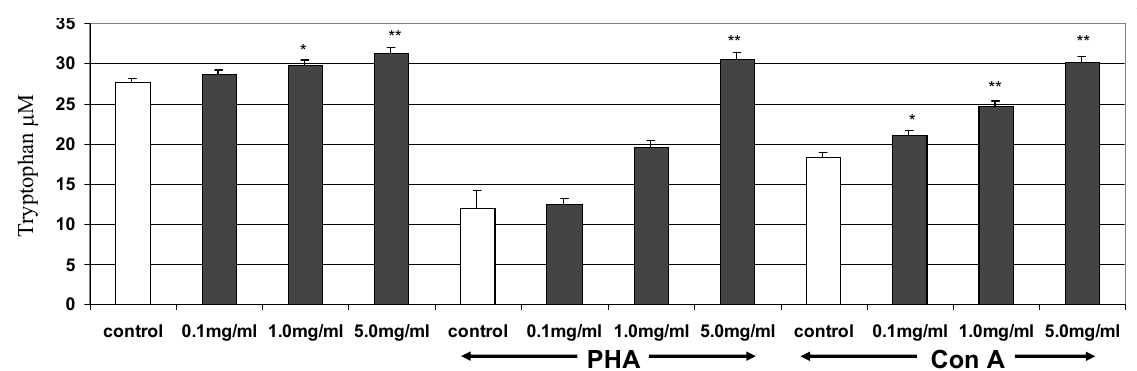
Figure 1: Concentration of tryptophan in supernatants of peripheral blood mononuclear cells unstimulated (left) or stimulated with mitogens phytohaemagglutinin (PHA; middle) and concanavalin A (Con A; right) with (black bars) or without (white bars) coincubation with 3 different concentrations of Nigella sativa seeds extracts for 48 hours ( ∗ P < 0.05, ∗∗ P < 0.001).